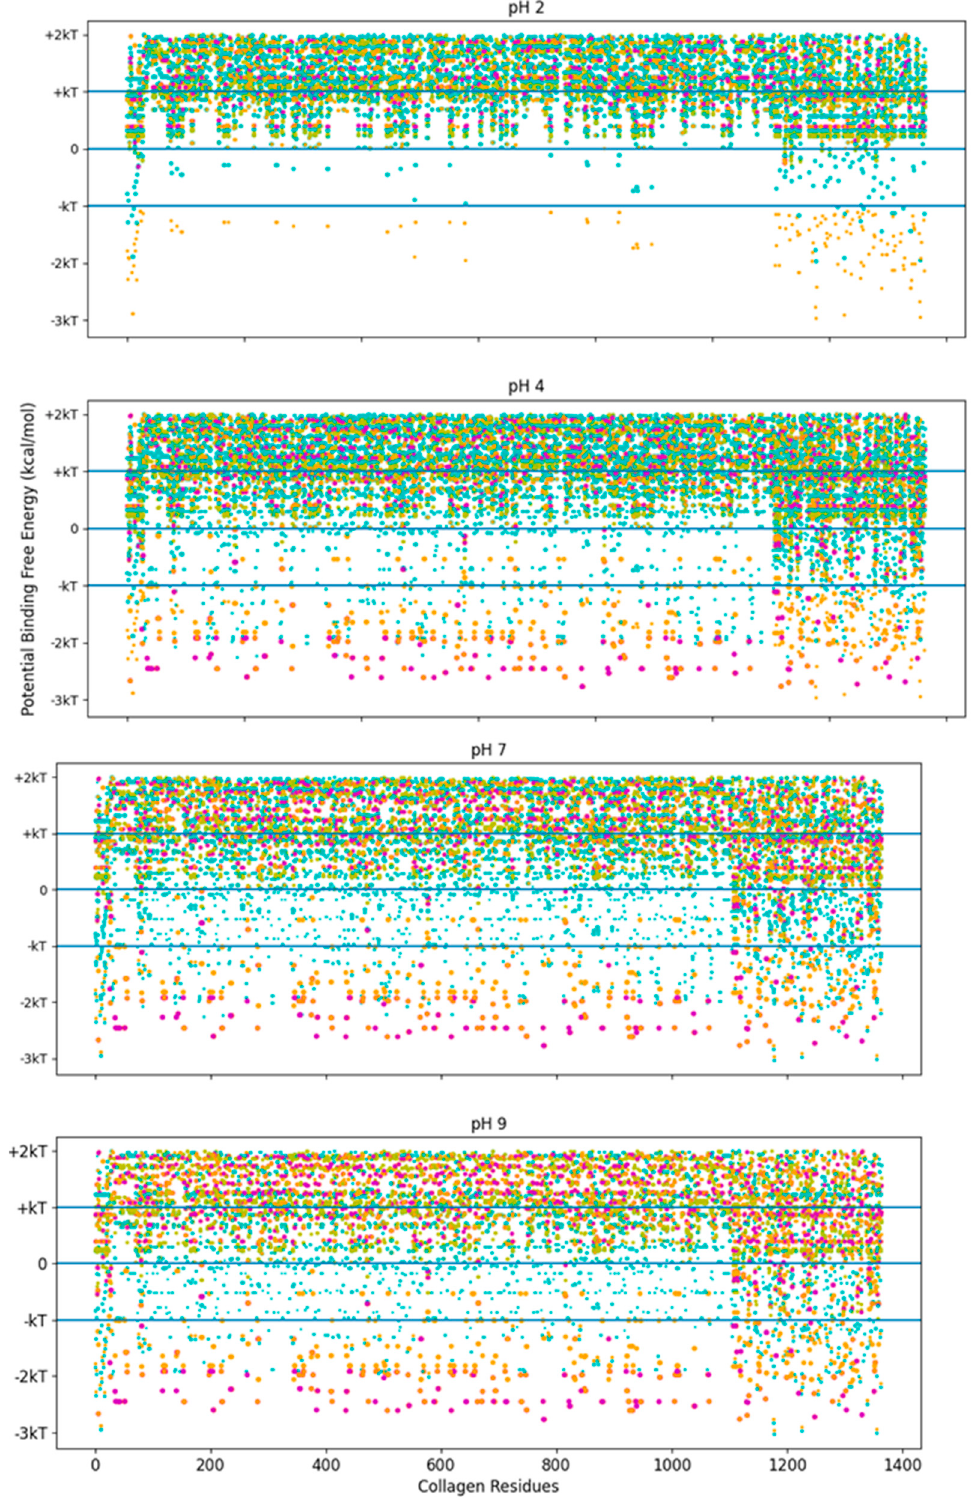
Figure 7. Free energy of binding estimates for sets of three adjacent residues for three different col- lagen-binding peptides for all residues of human collagen type I alpha chain 2 (COL1A2). Positive binding sites are energetically unfavorable, while negative binding sites are favorable. Binding sites significantly below − kT are likely to be stable. Each circle represents a potential three-amino-acid binding site between a peptide and collagen. The radius of the circle sizes is related to the magnitude of the polarity of the peptide residues. The potential binding free energy was calculated from the Wimley–White hydropathy scale values for the amino acids within the binding site. The potential binding sites are cyan for LRR-10 (LRELHLNNN), gold for the collagenase sub-sequence (SQNPVQP), magenta for the COLA2 sense peptide (TKKTLRT), and orange for the designed pep- tide (TKKLTLRT). The inserted leucine gave the peptide analogue a binding site with more potential binding free energy than LRR-10. TKKLTLRT is also not dependent on any of its residues changing protonation state to achieve this binding free energy. kT, which is the Boltzmann’s constant multi- plied by the temperature of 25 °C, is 0.693 kcal/mol. The trends of Figure 7 interactions may also apply to other extracellular matrix pro- teins. The potential binding sites of these peptides were evaluated for decorin, the protein origin of LRR-10, in Figures S3 and S4. First, we showed that collagenase binding peptide does not have strong electrostatic interactions with decorin, which is similar to COL1A2. The peptide sequence lacks charged residues, so strong electrostatic interactions with the collagenase peptide are lacking. For TKKTLRT and TKKLTLRT, electrostatic interactions are possible. We also highlighted an important characteristic of COL1A2, which is that the triple helix structure increases the availability of residues compared to other protein ter- tiary or quaternary structures. The LTL motif had many predicted hydrophobic interac- tions with decorin. However, due to energy landscape minimization constraints, hydro- phobic interactions are less likely to be available depending on the strength of hydropho- bic interactions. Therefore, the interacting partners for these interactions are likely to be interior for most proteins. However, if proteins are unfolded, then these interactions may become available. Similar to the LTL motif in the high-stability collagen-binding peptide, the LHL motif in LRR-10 was predicted to have many strong hydrophobic interactions with decorin if those sites are available.